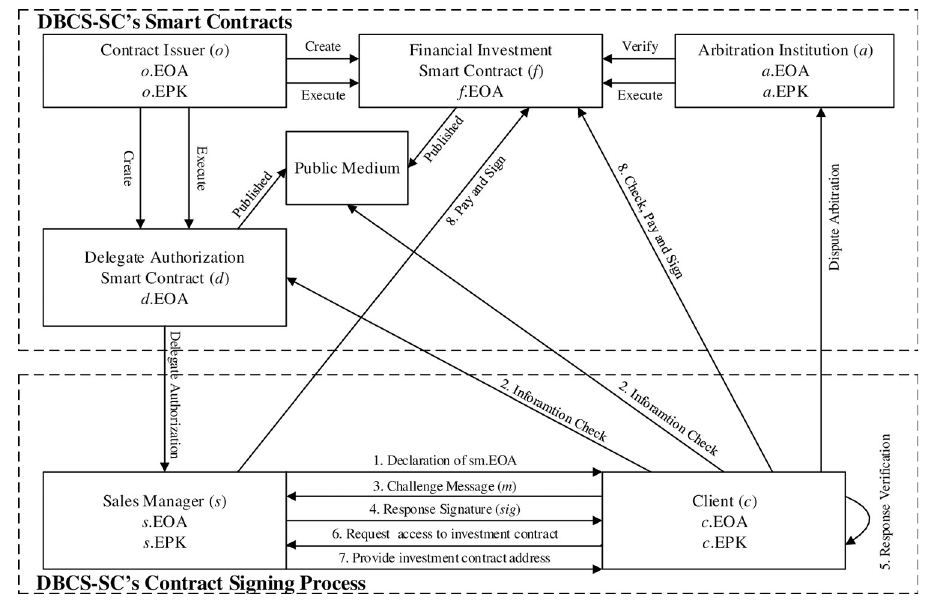
Fig 2. The framework of